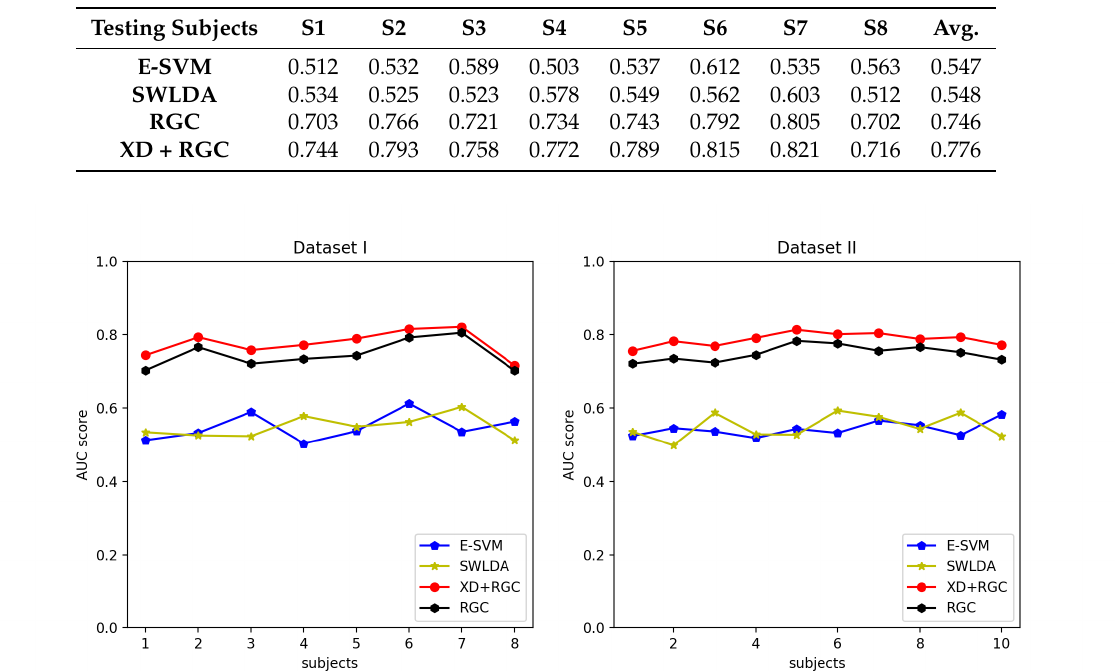
Figure 6. One-to-One transfer learning result of: Dataset I ( left ); and Dataset II ( right